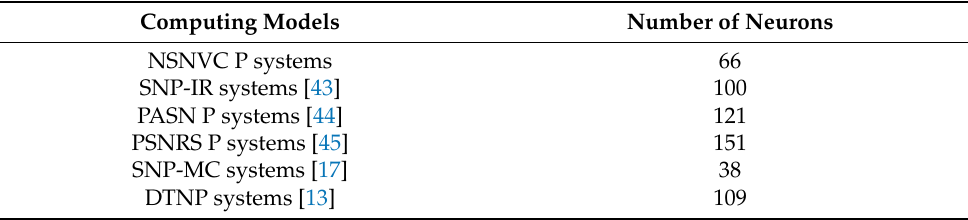
Table 2. Comparison of different computing models in the number of neurons.